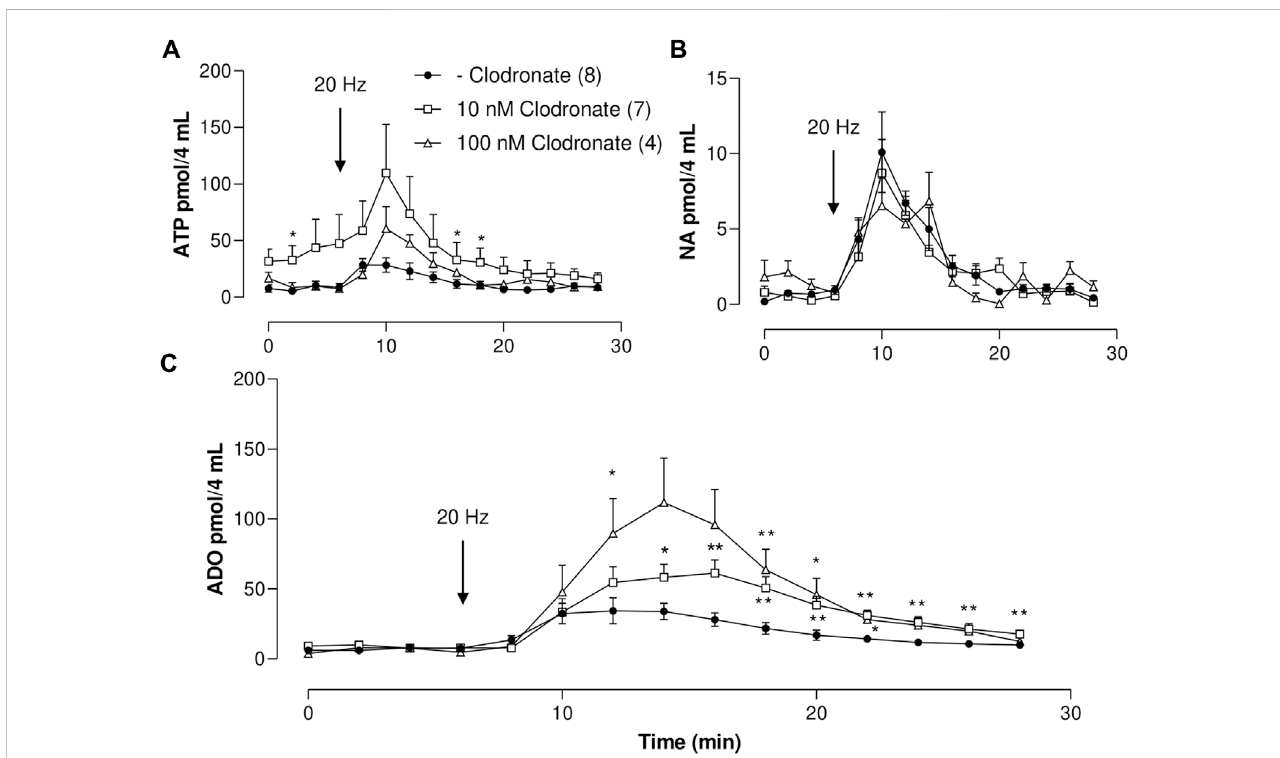
FIGURE 1 ATP, ADO, and NA out fl ow to the mesenteric perfusate elicited by electrical nerve endings stimulation in mesenteries perfused in the absence or presenceofeither10or100 nMclodronate;atimecoursestudy. (A) Over fl owofATP, (B) NAover fl ow,and (C) ADOover fl ow.Mesenterieswereperfusedprior to,during,andafternerveendingsdepolarization,intheabsence(closedcircles, n =8)orpresenceofeither10 nMclodronate( n =7,opensquares)or100 nM clodronate ( n = 4, open triangles). The arrows indicate the initiation of the 1-min nerve endings depolarization (20 Hz, 1 ms trains of 60 V) to elicit co- transmitter release from the nerve terminals. Symbols indicate mean values; bars the S.E.M. *, p < .05; **, p < .01 unpaired t-test compared to perfusions without